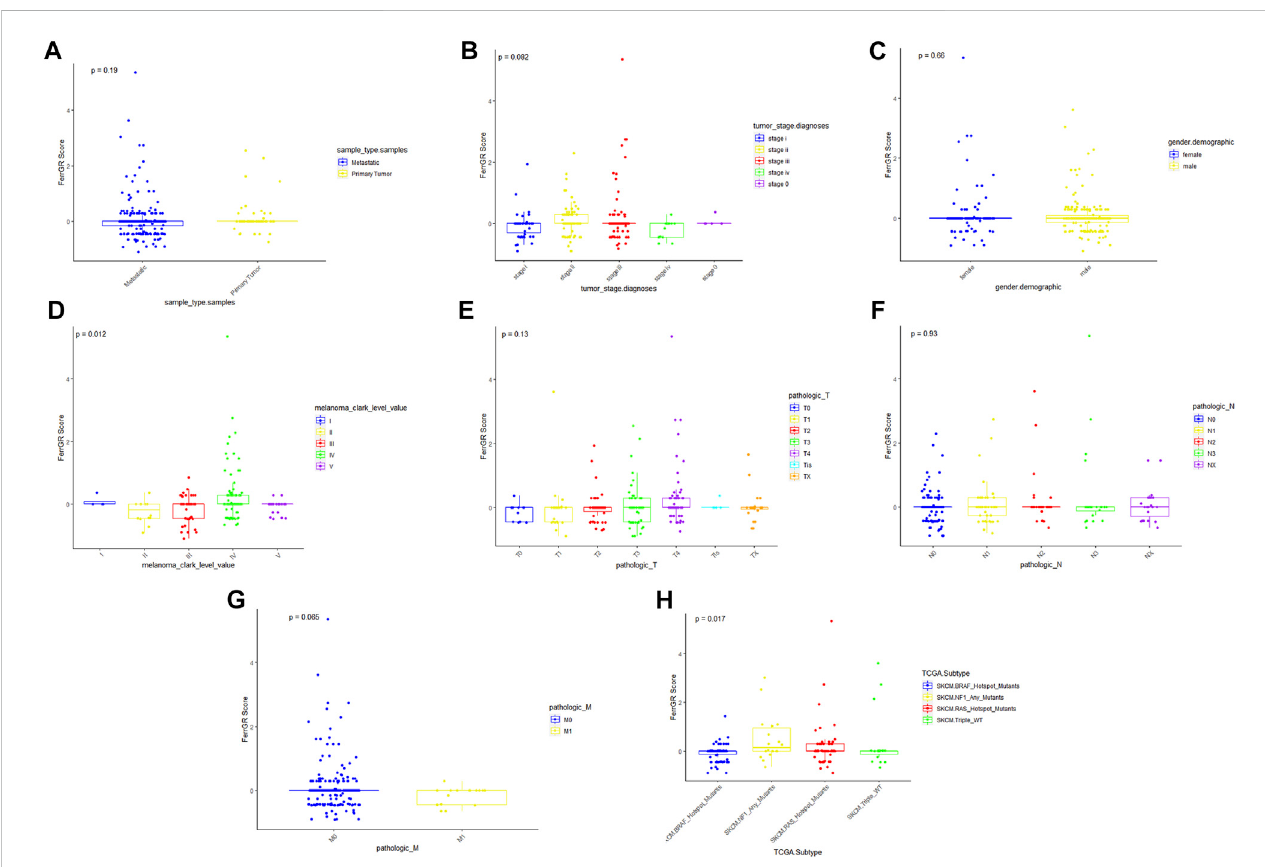
FIGURE 3 Relationships between the FerrGR score and clinicopathological features. The boxplots showed whether the FerrGR score was correlated with pathologicalfeaturesinSKCMpatients,including (A) sampletype, (B) tumorstage, (C) gender, (D) Clarklevel, (E) Tstage, (F) Nstage, (G) Mstage,and (H) TCGA